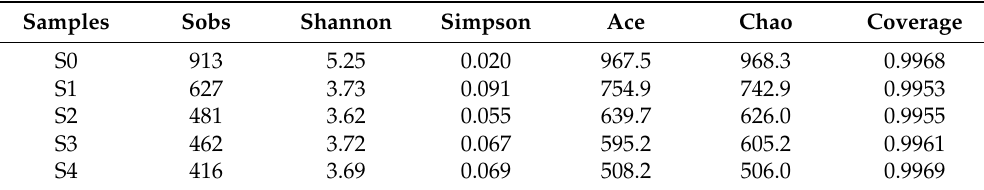
Table 2. Microbial alpha diversity of five samples (seed sludge, S0; C / N = 4.64, S1; C / N = 3.87,